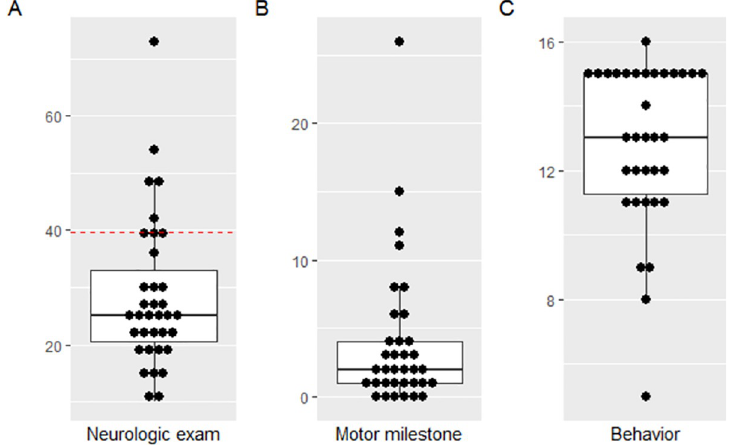
Fig 2. Hammersmith Infant Neurological Examination scores for children with Congenital Zika Syndrome associated microcephaly. A) The main section–neurological exam; B) The second section–motor milestone; and C) The third section—child behavior.